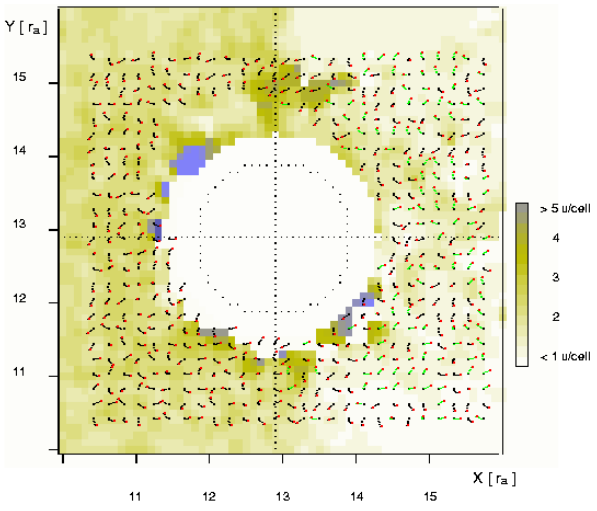
Fig. 6. Distribution of the energy density in the equatorial plane at t =46s. The electron velocity field ( V x , V y ) is overplotted. Each vector is represented by dots – the vector commences with a bold black dot and ends with a bold red one. The night-side velocity vec- tors of positive y-component are displayed in green. Energy density unit is 30keV / m 3 .